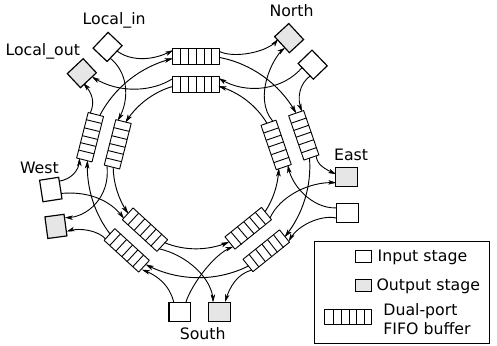
Figure 1. The Rotary router